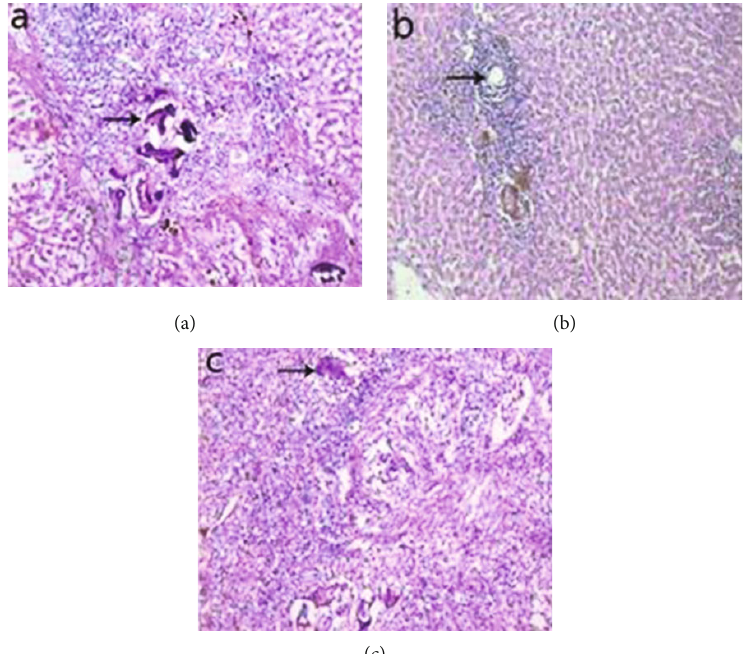
Figure 16: Histological section of infected treated with 600 mg/kg Coriandrum sativum group staining with H&E: (a, b) liver revealed multiple epithelioid granulomas around deposited bilharzia ova × 200; (c) spleen showing some degenerated ova, surrounded by lympho- epithelioid cellular in fl ammatory cellular in fi ltration ( ×